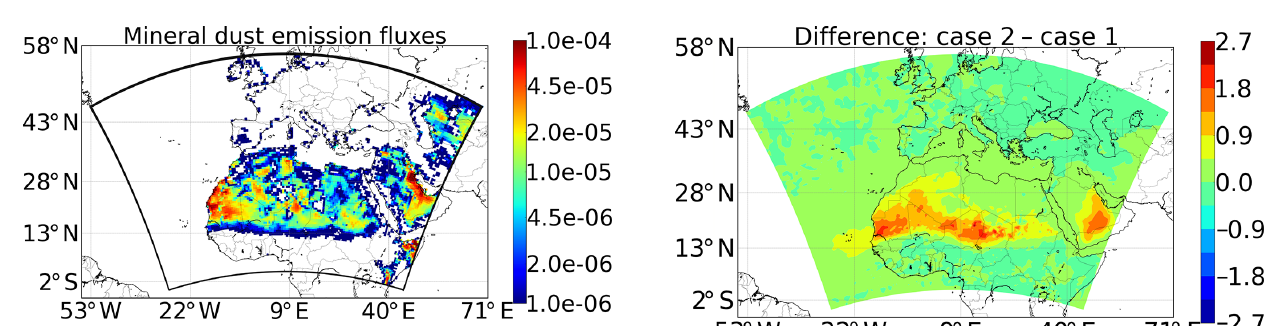
Figure 9. Difference map of WRF temperature at 2m from the sur- face averaged over the simulated period ranging from 1 June to 14 July (in